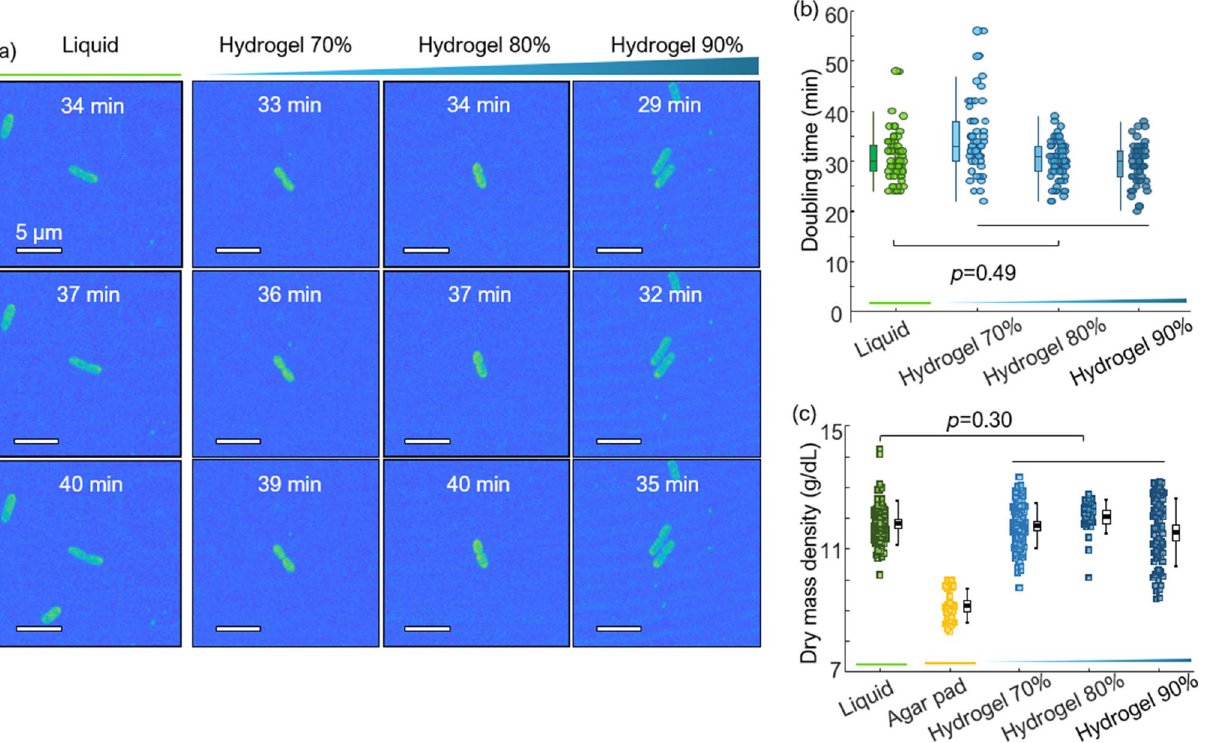
Figure 4. ( a ) MIP visualization of 3D RI tomograms of dividing K. pneumoniae over time in different media: a liquid medium, a hydrogel 70%, a hydrogel 80%, and a hydrogel 90% medium. ( b ) Distribution of K. pneumoniae doubling time in the different media. ( c ) Dry mass density distributions for K. pneumoniae at 0 min in various media. For ( b ) and ( c ) the results of the Wilcoxon rank-sum test p -value of the liquid and the pooled hydrogel environments are